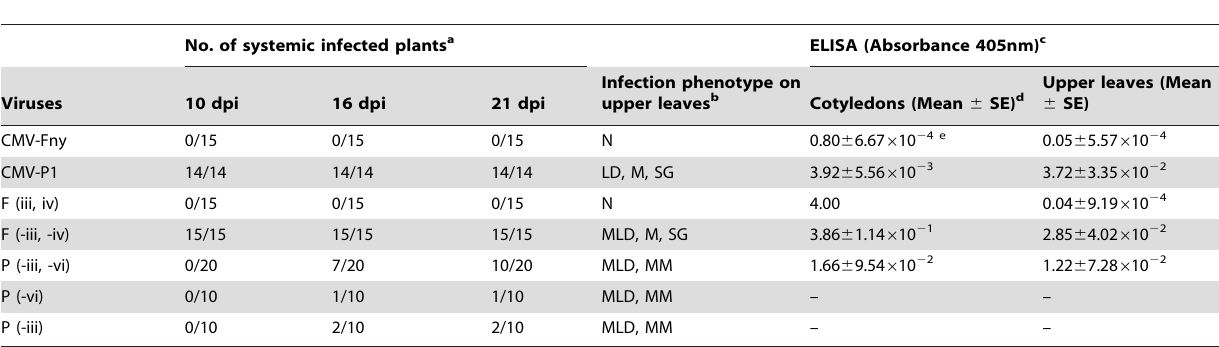
Figure 4. Schematic diagram of CMV-Fny- and CMV-P1-derived amino acid substitution mutants. The positions of the amino acid substitutions are located at the top of each amino acid sequence. Fny- and P1-derived amino acids are indicated in blue and red, respectively. At 21 days post-inoculation, accumulation of CMV was detected by ELISA. + , presence of virus; 2 , absence of virus; R, resistant; S, susceptible. doi:10.1371/journal.pone.0043136.g004 Table 2. Summary of experiments with helicase domain mutant